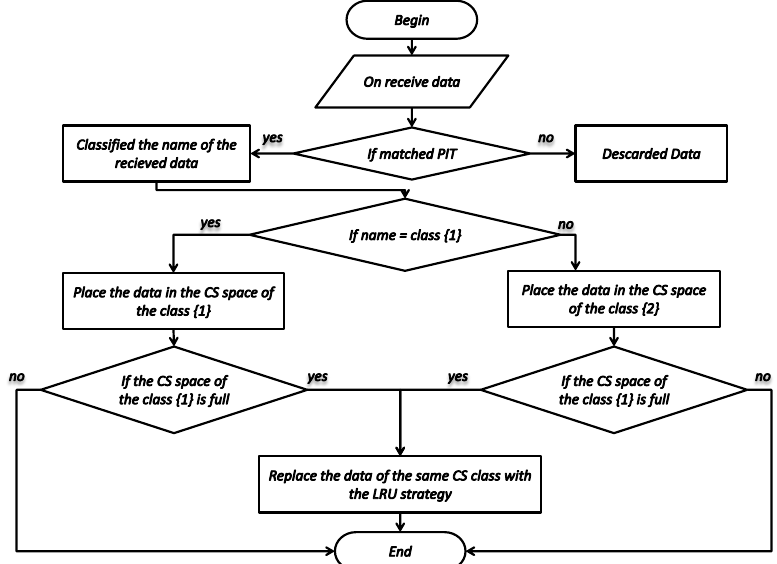
Figure 3. Data placement and replacement